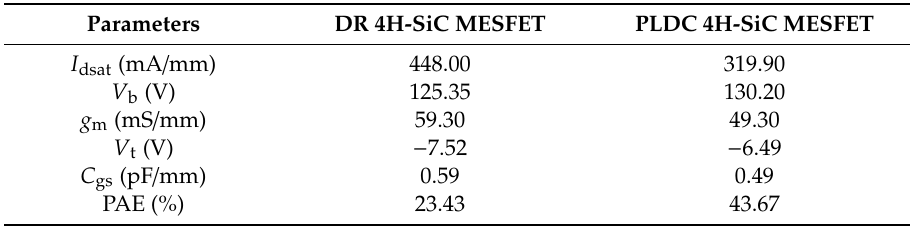
Table 1. Comparison of performance parameters of the two